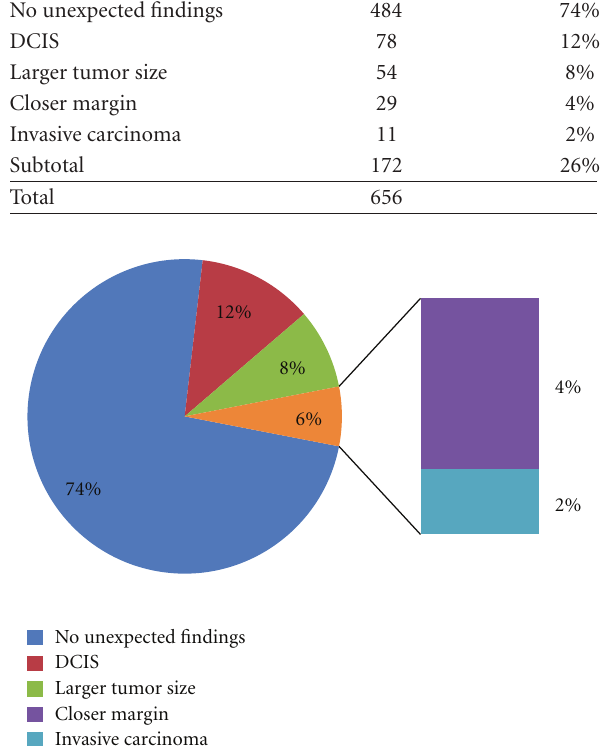
Figure 1: Distribution of potentially clinically significant unex- pected findings in 656 large format cases from 2004 to May 2012. Tumor is defined as DCIS or